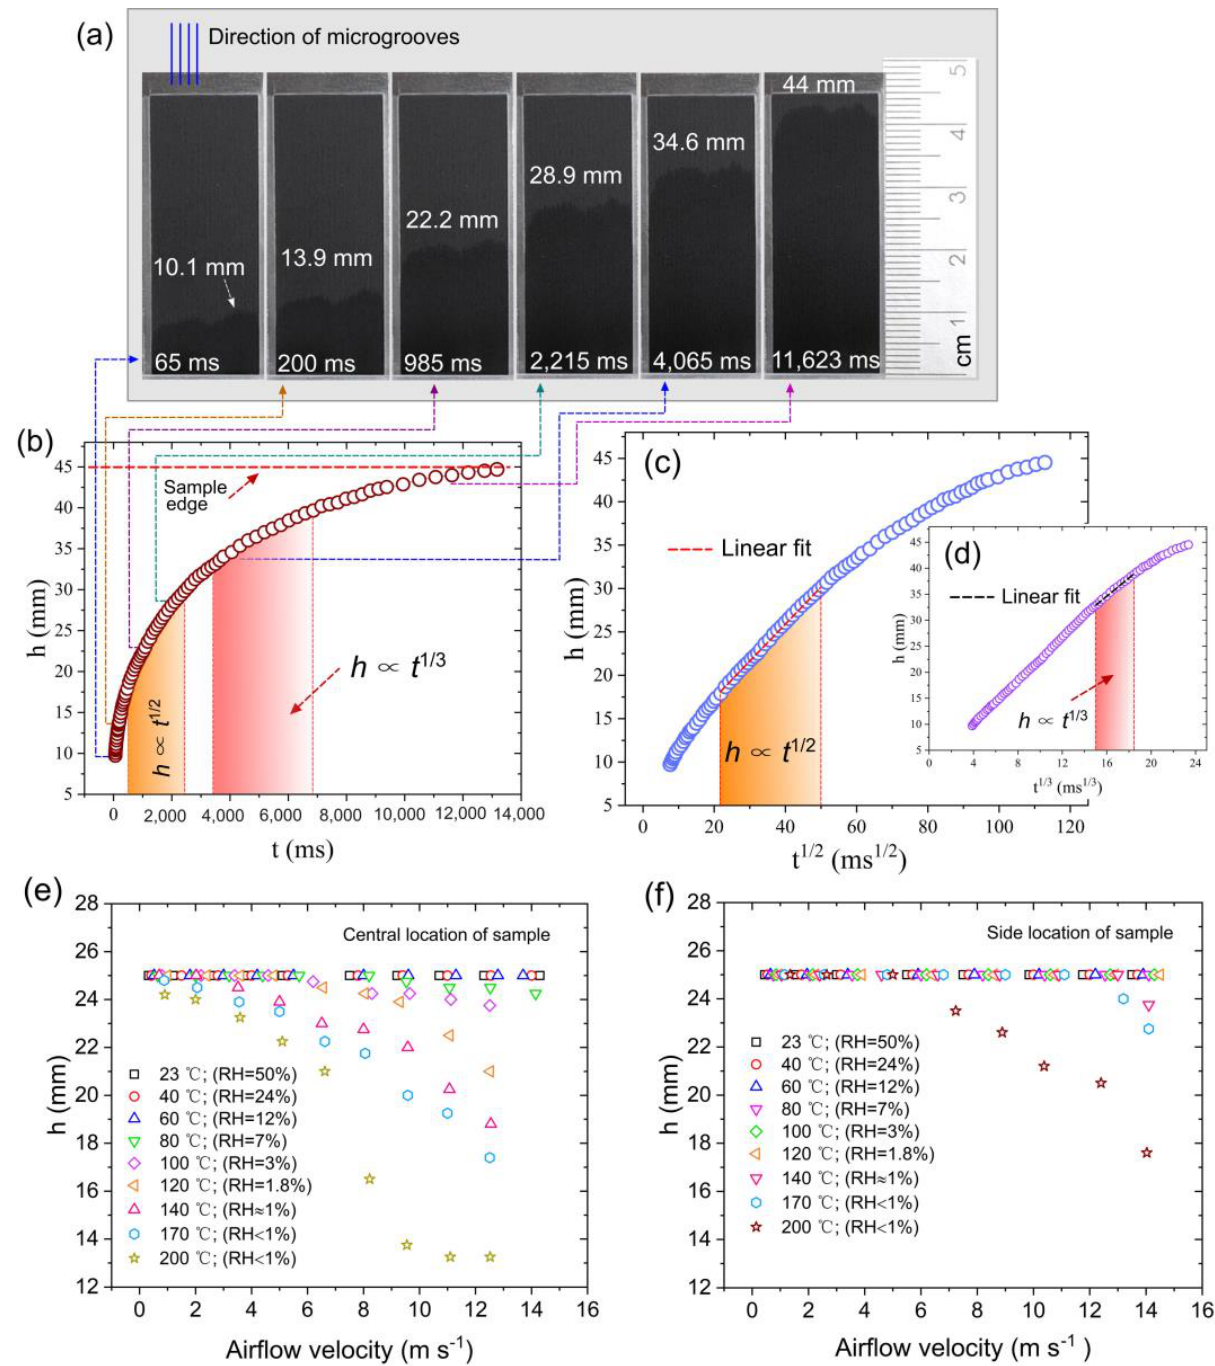
Figure 4. The overall dynamics of the water capillary rise on the laser-treated sample surface. ( a ) Snapshots of water rise on the surface of vertically standing sample. ( b ) Spreading distance as a function of time. ( c ) Spreading distance as a function of t 1/2 . ( d ) Spreading distance as a function of t 1/3 . ( e ) Spreading height of the wet area at central location of the sample in the wind tunnel as a function of airflow velocity at various temperatures and humidities. ( f ) Spreading height of the wet area at side location of the sample in the wind tunnel as a function of airflow velocity at various temperatures and humidities.